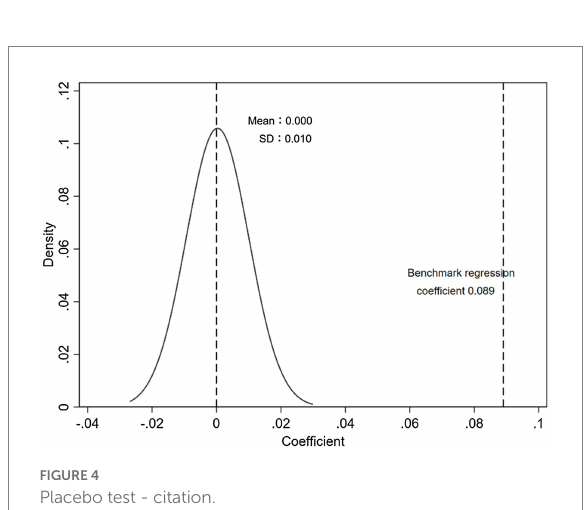
FIGURE 4 Placebo test -